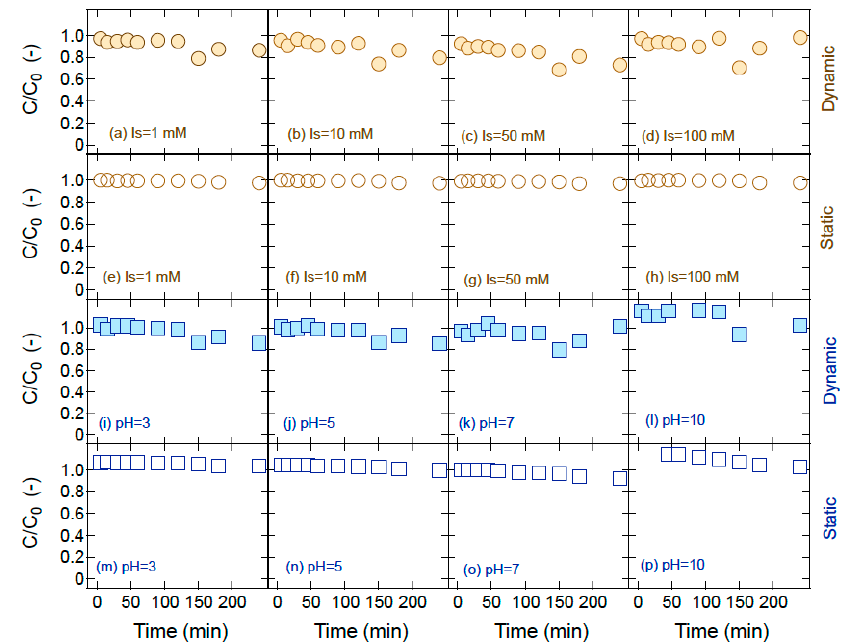
Figure 2 . TM normalized concentrations during the batch adsorption experiments onto quar tz sand Mass recoveries and maximum concentrations for TM with changing Is remained Figure 2. TM normalized concentrations during the batch adsorption experiments onto quartz sand under: dynamic conditions and four di ff erent Is values ( a – d ), static conditions and four di ff erent Is practically constant. However, the lowest mass recoveries were obtained for Is = 1 mM under: dynamic conditions and four different Is values ( a – d ), static conditions and four different Is values ( e – h ), dynamic conditions and four di ff erent pH values ( i – l ), and static conditions and four (97.2%) and for Is = 10 mM (95.3%) (see Table 2). Similarly, the mass recoveries for TM di ff erent Is values ( m – p ). Here the initial TM concentration is C 0 = 10 mg/L. values ( e – h ), dynamic conditions and four different pH values ( i – l ), and static conditions and four with changing pH did not exhibit substantial variability. Additionally, mass recoveries different Is values ( m – p ). Here the initial TM concentration is C 0 = 10 mg/L. approached 100% for some pH values. The normalized TM breakthrough concentrations (C/C 0 ) and the corresponding fi tt ed curves as a function of time are presented in Figure 3 for the transport experiments in water-saturated columns packed with quar tz sand. The e ff ect of four di ff erent ionic strength values (Is = 1, 10, 50, and 100 mM) is shown in Figure 3a–d, whereas the e ff ect of